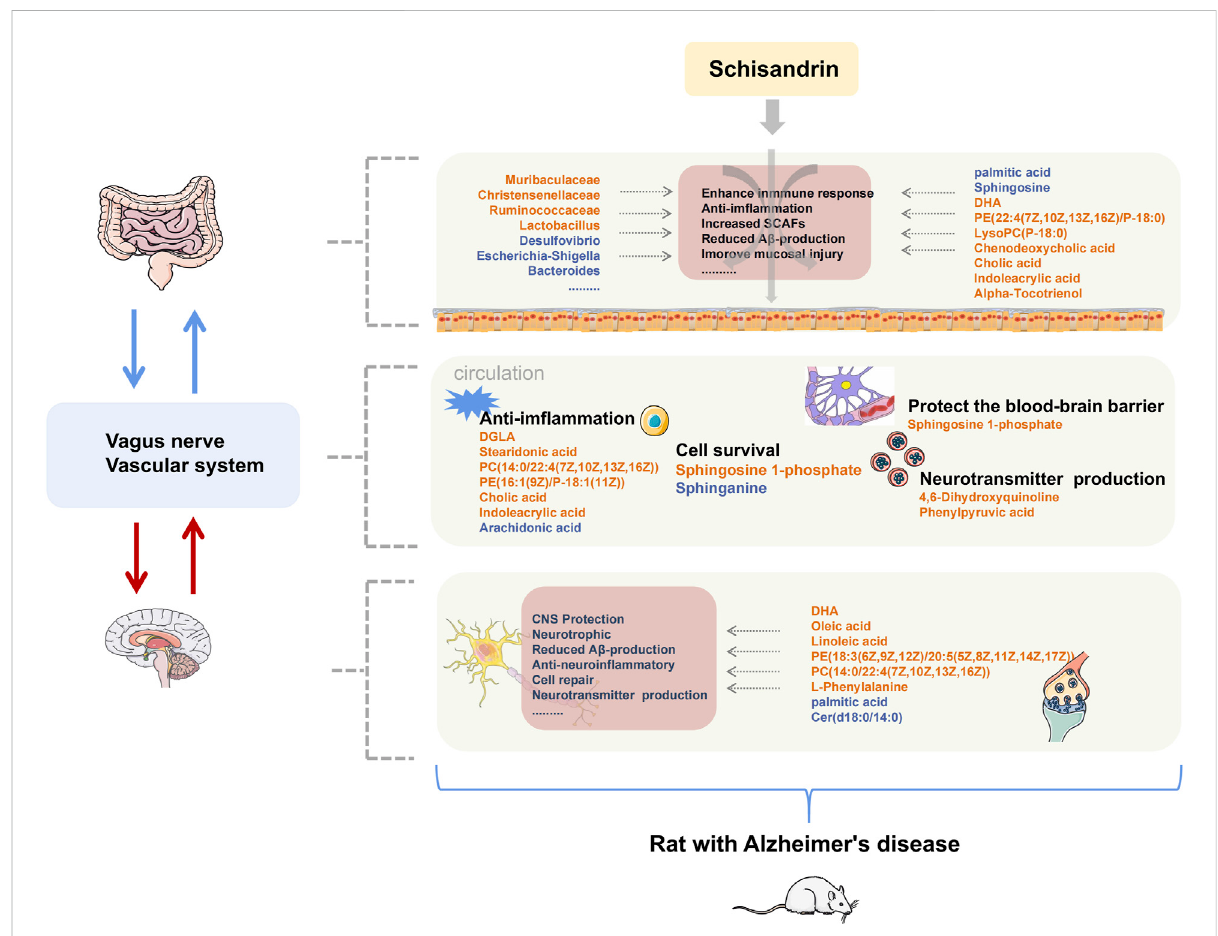
FIGURE 12 Summary ofchanges inrats withAD aftertreatmentwith schisandrin. ThefontcolorofendogenousmetabolitesandGMrepresentthecontent level and abundance, orange represents an increase, and blue represents a